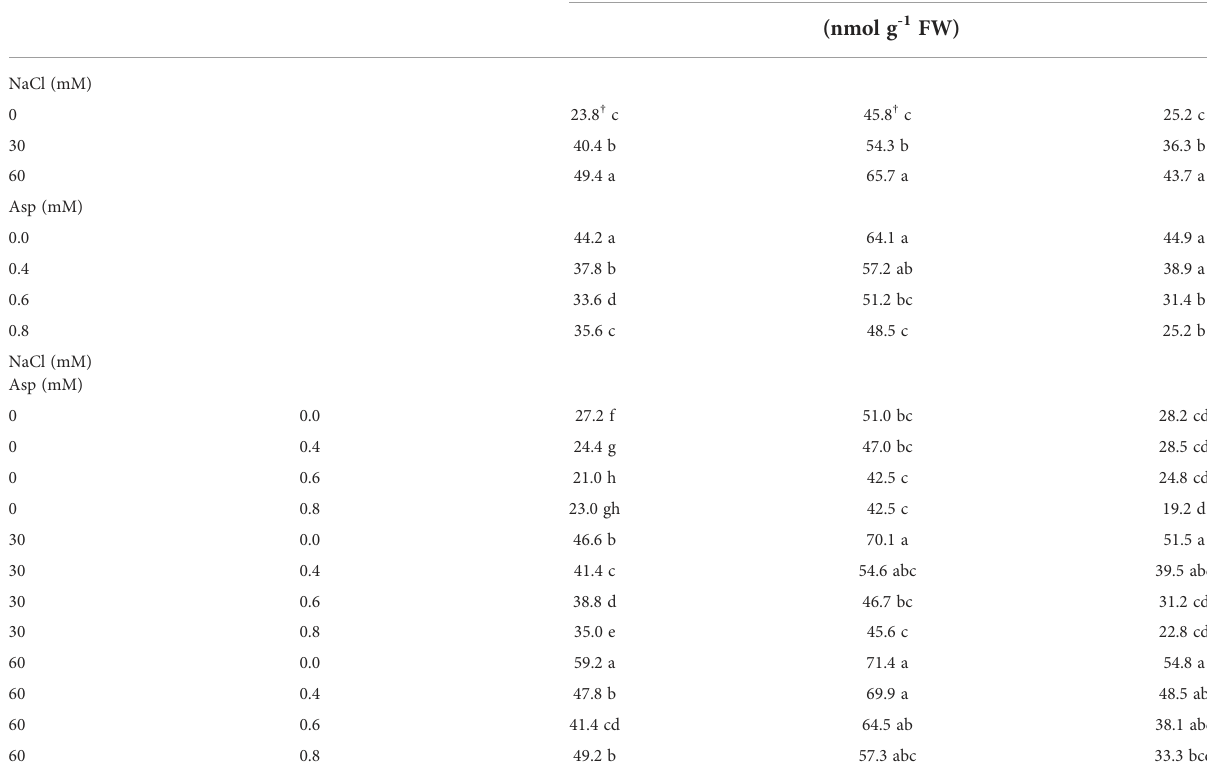
TABLE 3 Effect of aspartic acid (Asp) on hydrogen peroxide (H 2 O 2 ), lipid peroxidation (MDA), and aldehyde (ALD) in wheat plants grown under salt stress (NaCl) for 60 days.